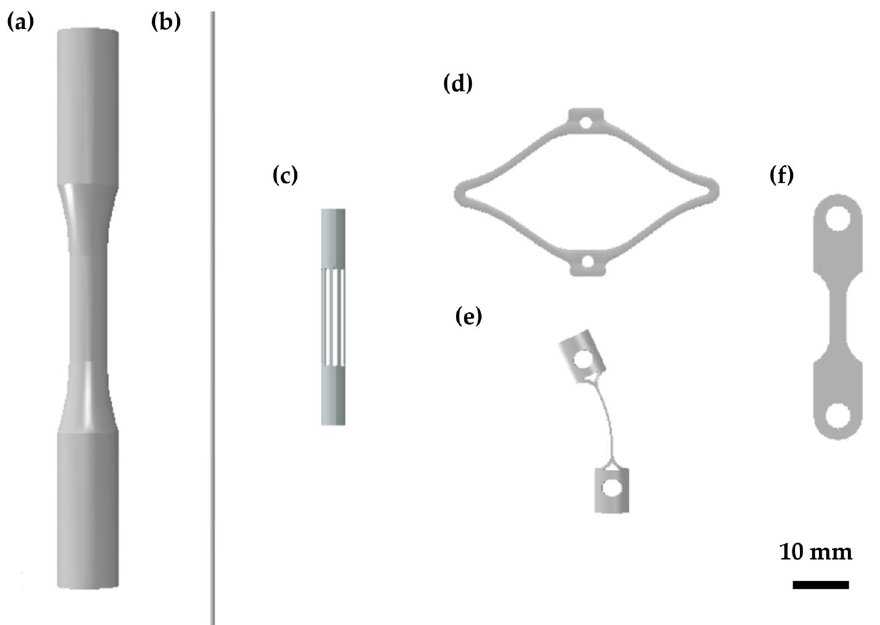
Figure 3. Graphical representation of the most common kinds of samples adopted for characterizing Ni-Ti fatigue behavior: ( a ) cylindrical bulk sample [21,22]; ( b ) single-wire specimen [24]; ( c ) laser-cut multi-wires sample [27]; ( d ) surrogate diamond-shaped sample [28]; ( e ) surrogate C-specimen [29]; ( f ) laser-cut macroscopic thin sample [31].